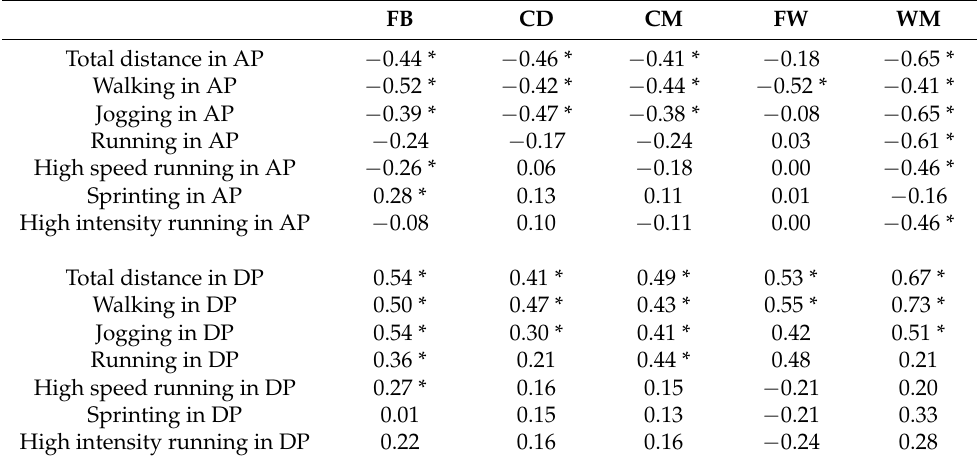
Table 3. Correlations between RP in AP and DP of game and total points earned at the end of group stage of UCL.